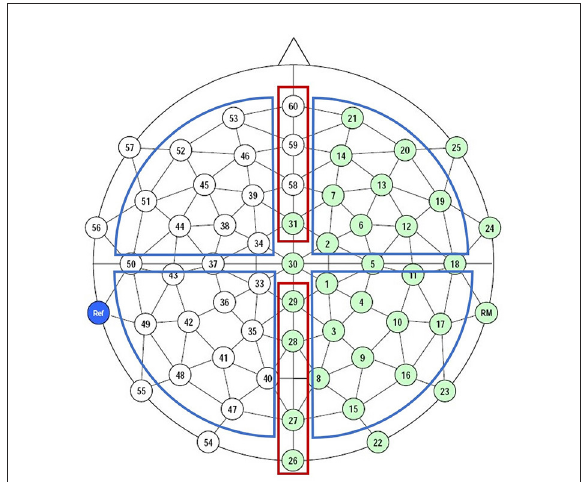
FIGURE1 Layout of electrodes. The two red boxes indicate electrodes included in the midline analysis. The four blue boxes indicate electrodes included in the quadrant analysis.